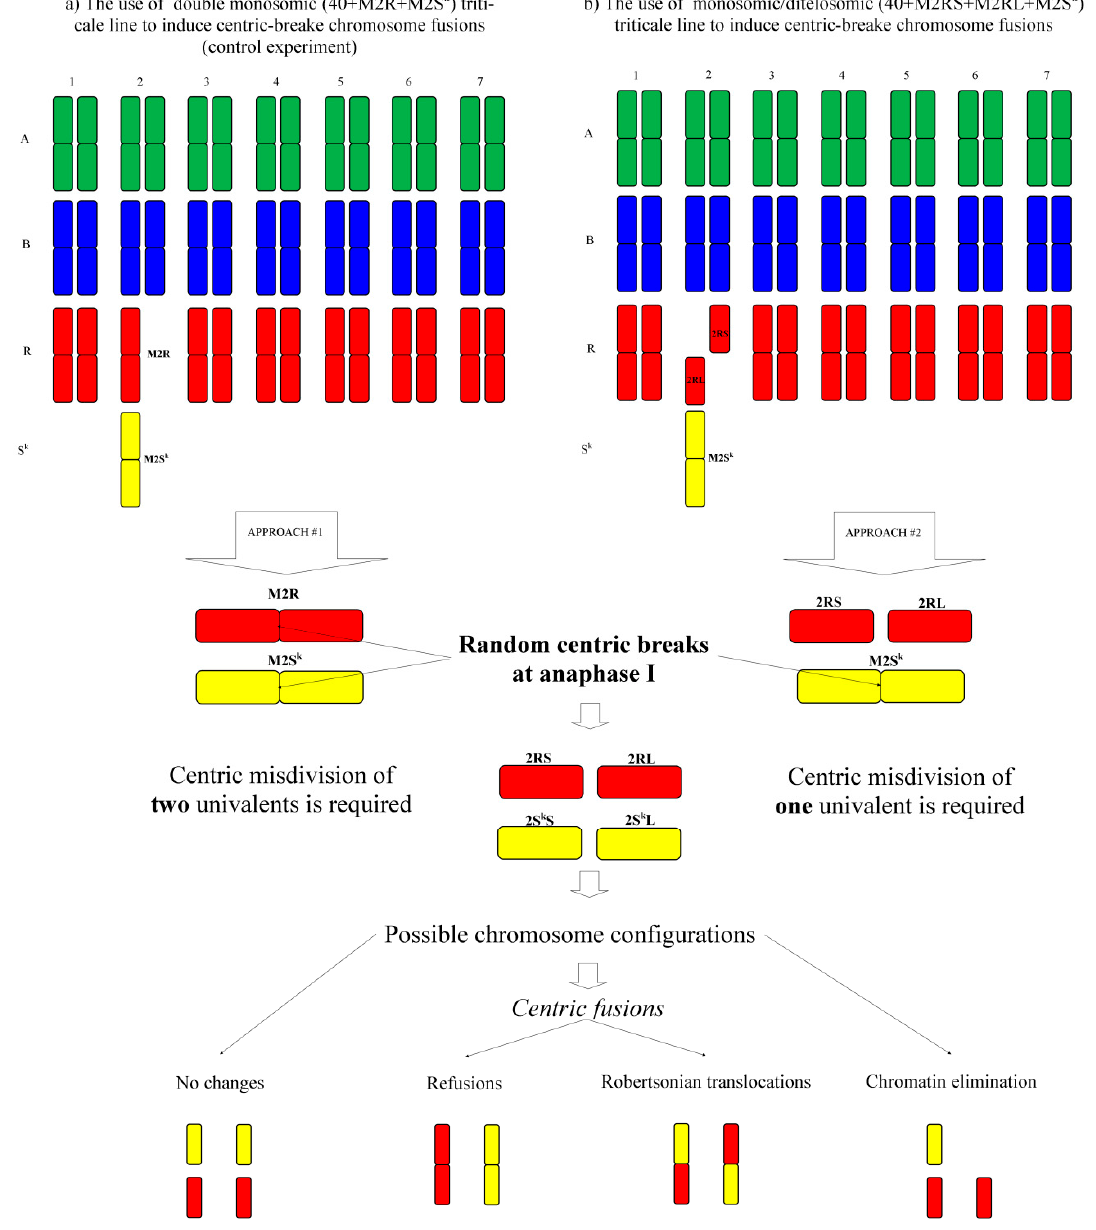
Figure 1. Ideogram of the two contrasting approaches for the recovery of Robertsonian translocations.